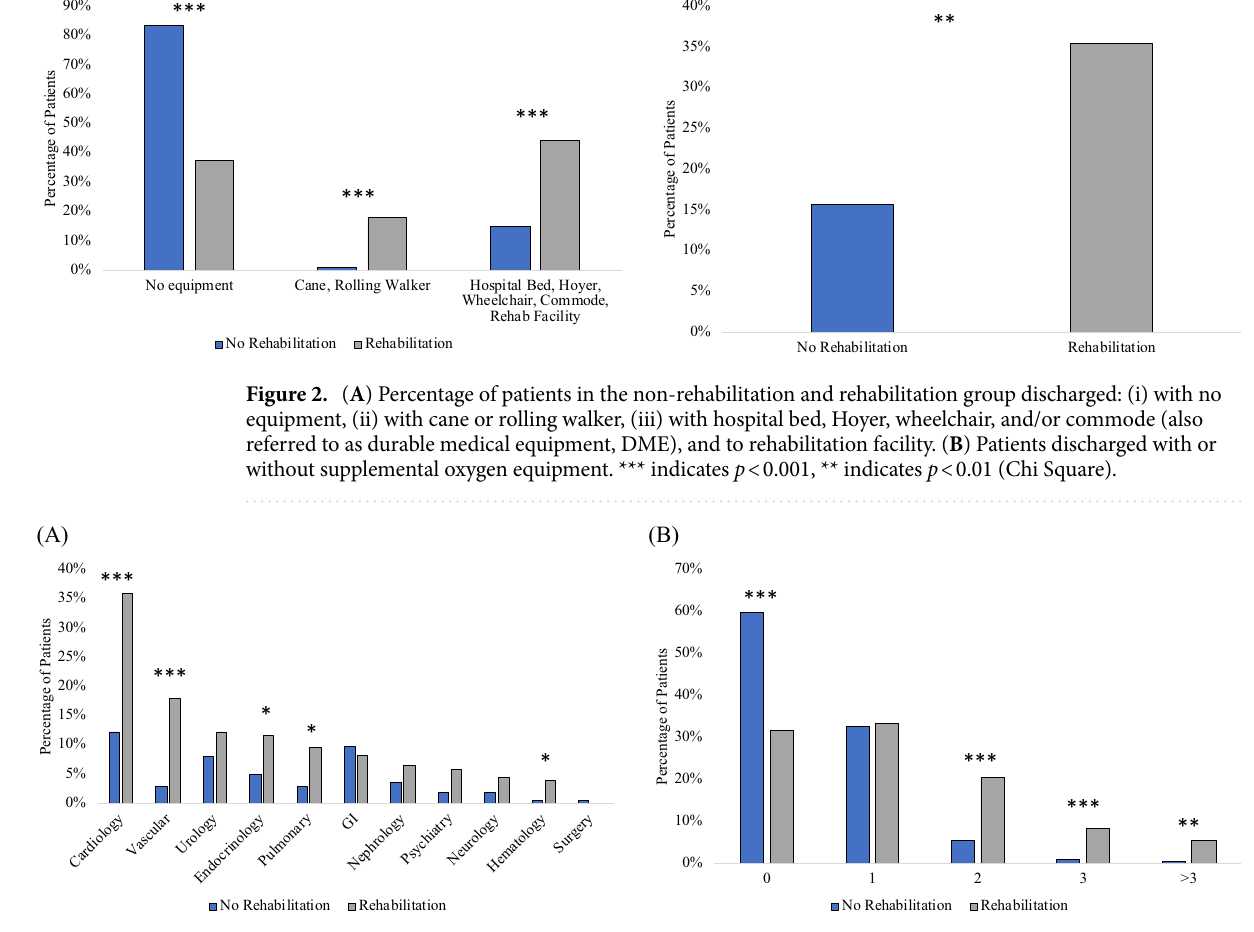
Figure 3. ( A ) Histogram of medical follow-up recommendations, and ( B ) percentages of patients with number of follow-up recommendations. *** indicates p < 0.001, ** indicates p < 0.01, * indicates p < 0.05 (Chi